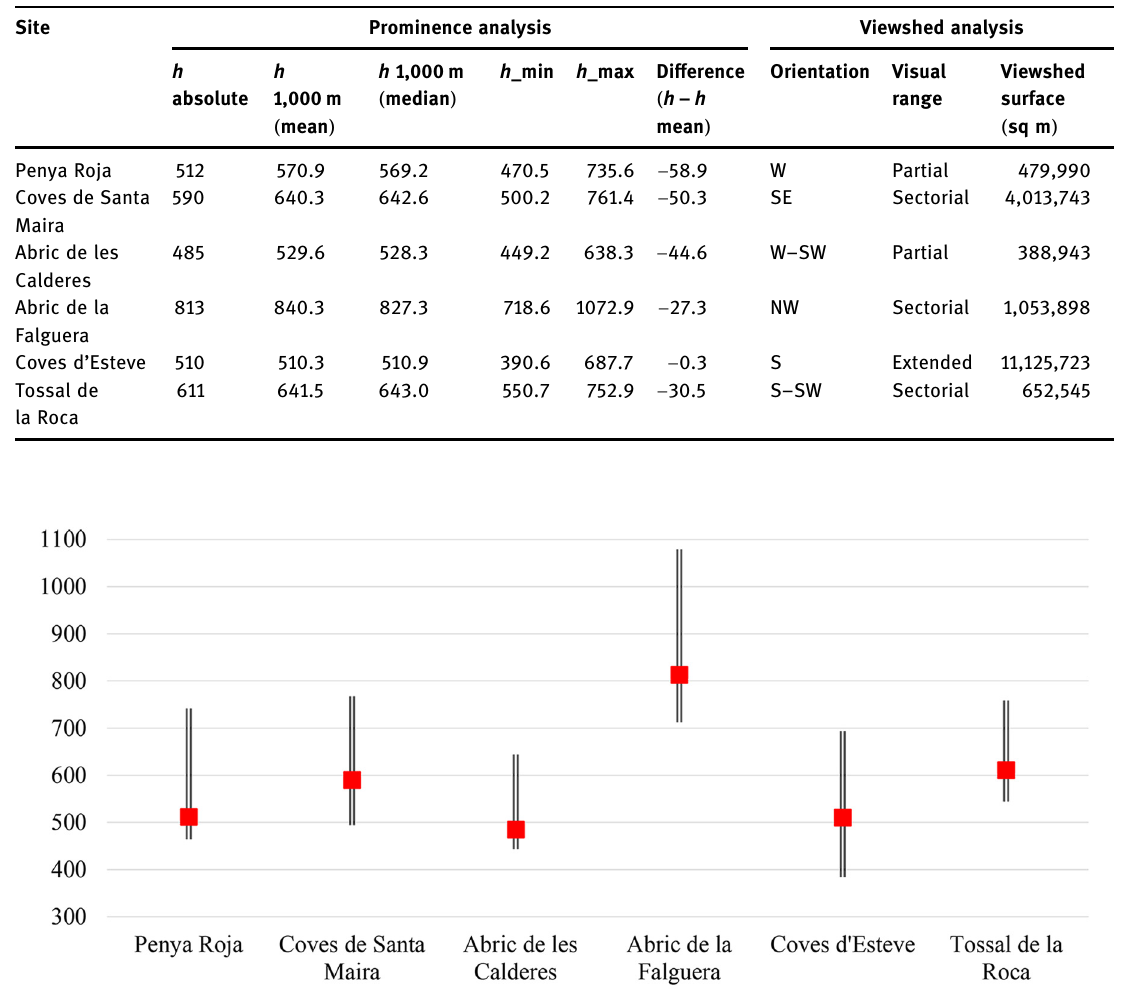
Table 1: Prominence and viewshed analysis from rock shelters with Early Neolithic occupations